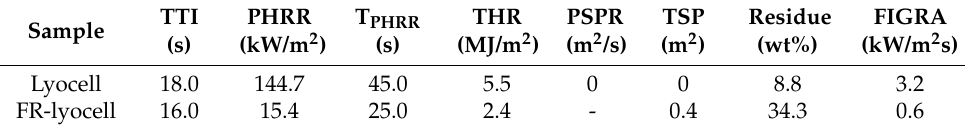
Figure 10. Conical calorimetry images of FR − lyocell before ( a ) and after ( b ) combustion. Table 5. Parameters of lyocell and FR − lyocell fabrics acquired from CC